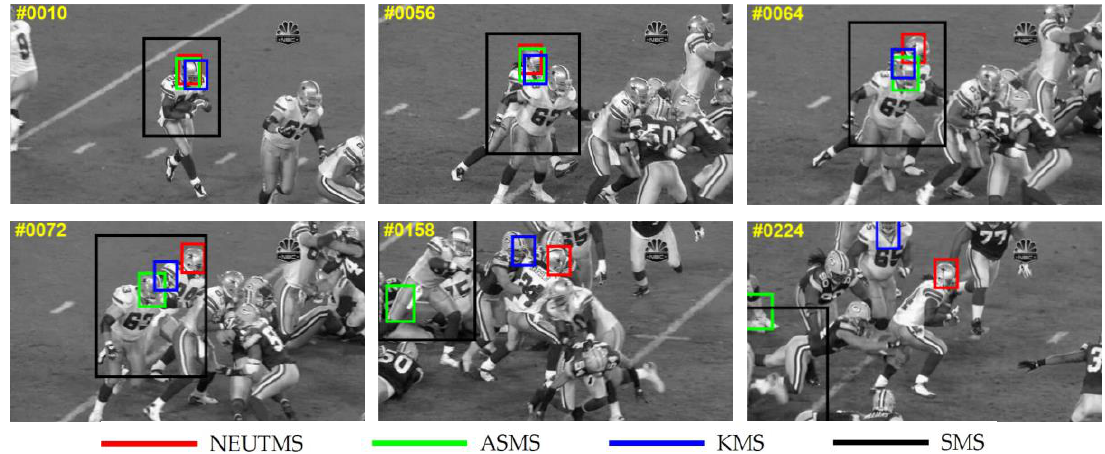
Figure 4. Screenshots of tracking results of the video sequence used for testing ( Football , target is selected in frame #1).